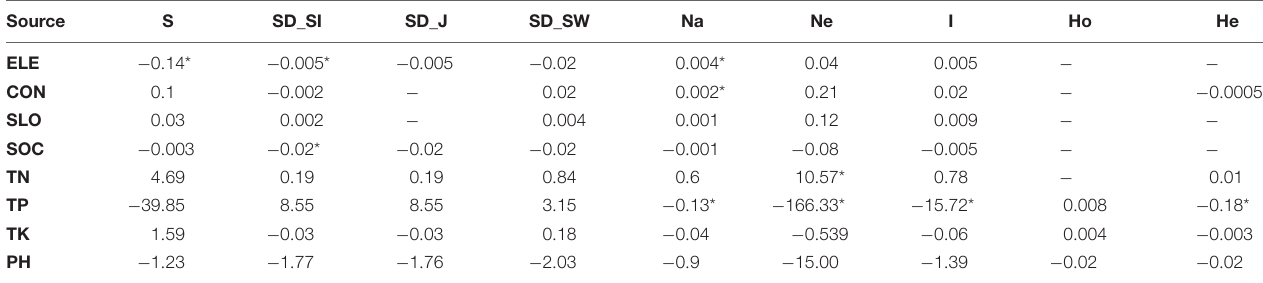
TABLE 1 | Effects of soil and topography on the SD and GD indices for species diversity (SD) and genetic diversity (GD) in the subplots (S, species richness; SD_SI, Simpson index; SD_J, Pielou index; SD_SW, Shannon-Wiener index; Na, observed number of alleles; Ne, effective number of alleles; I, Shannon’s information index; Ho, observed heterozygosity; He, expected